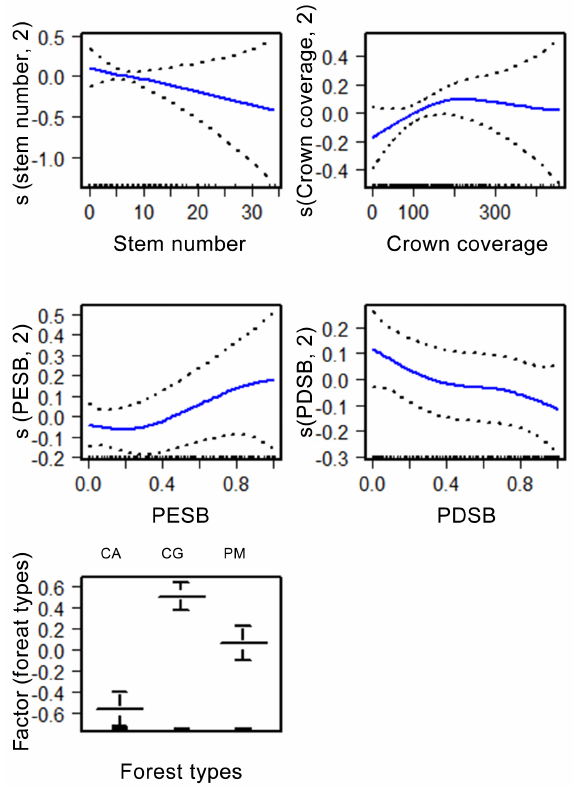
Figure 3. Partial effects of stem number, crown coverage (m 2 ) , the proportion of evergreen conifer species to total stand BA (PESB), the proportion of deciduous species to total stand BA (PDSB), and forest types (calculated for overstorey trees with height larger than average stand height) on the LAI values observed in January in P. massoniana – L. glaber , C. axillaris , and L. glaber – C. glauca forests.